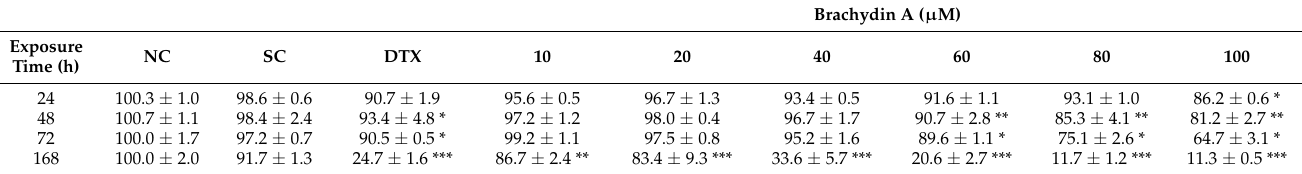
Table 2. Cell viability (%) of DU-145 spheroids after 24, 48, 72, and 168 h of exposure with Brachydin A (BrA) and their respective controls, as assessed using the resazurin assay 1